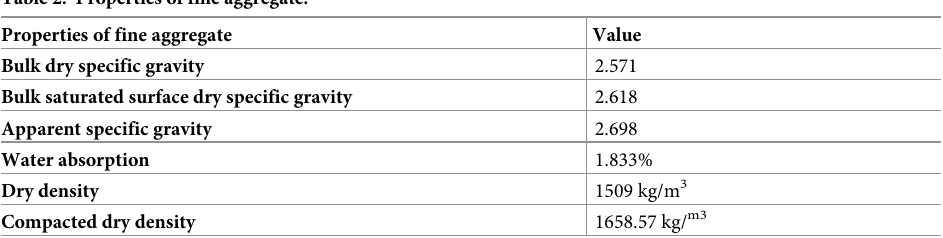
Table 2. Properties of fine aggregate.